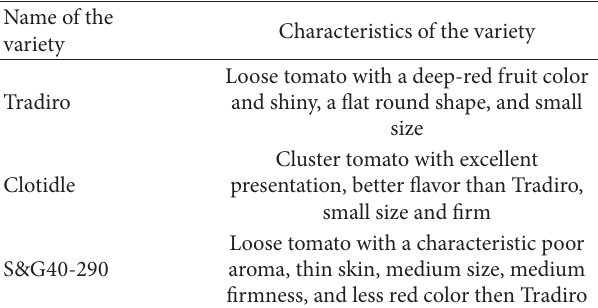
Table 1: Standard varieties of collected tomato samples. Name of